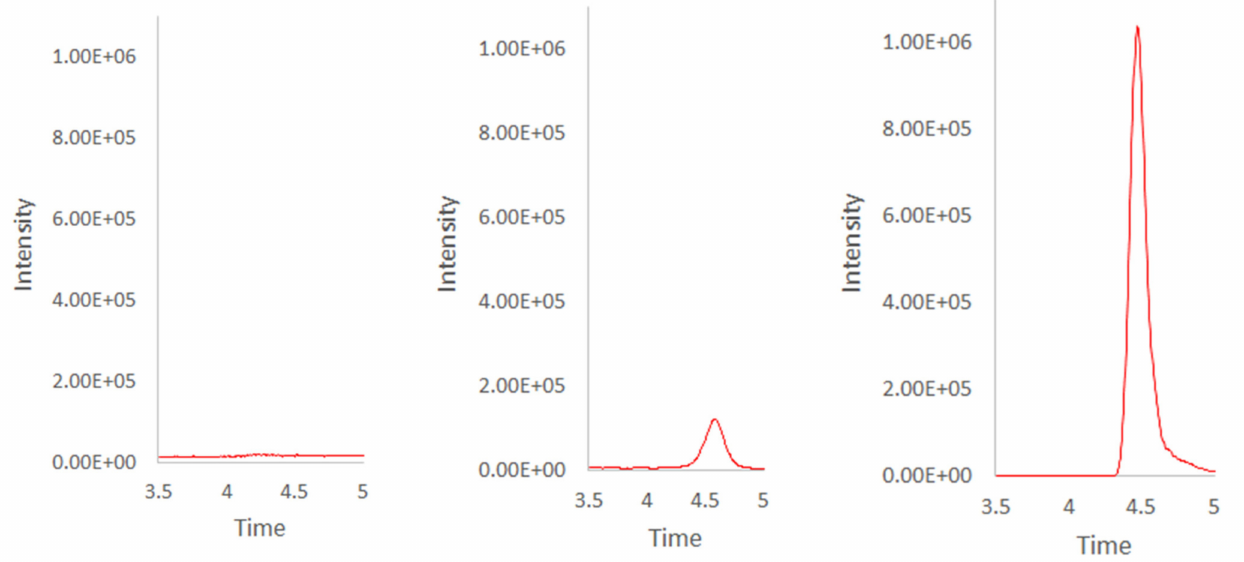
Figure 1. HILIC-MS/MS of ( A ) a “blank” blood sample, a sample that was left for 60 min at room temperature; ( B ) blank sample spiked at LLOQ; ( C ) a real clinical blood sample (concentration 0.05 µ M).